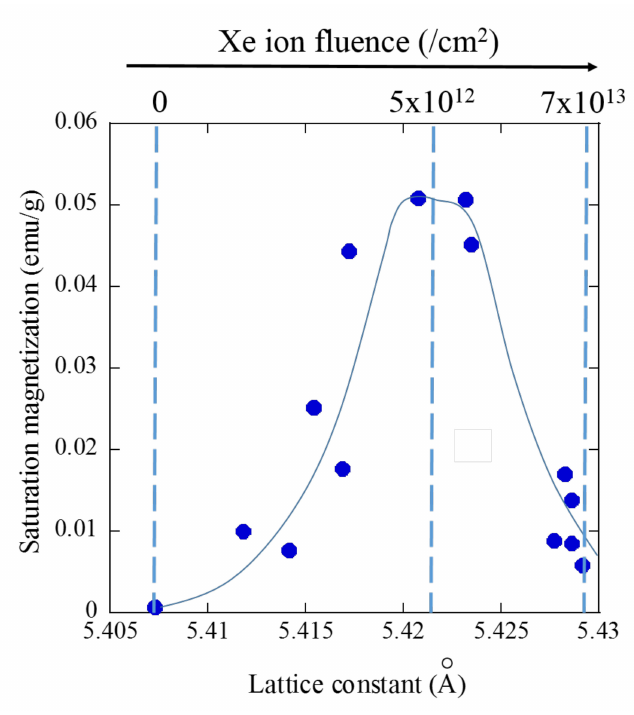
Figure 12. Correlation of a lattice constant with saturation magnetization. Xe ion fluence is also shown at the upper x